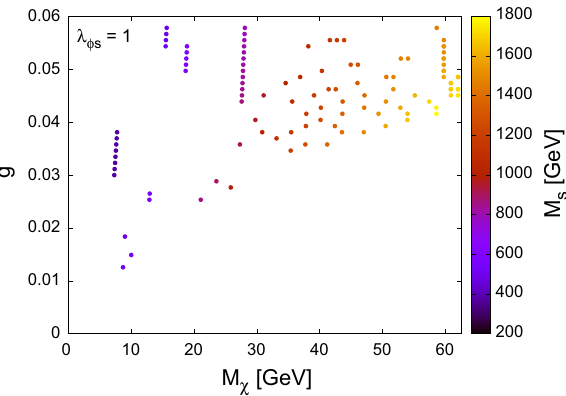
Fig. 14 Scatter points depict the ranges of parameter space in the mass of fermionic DM and g coupling for different values of M s , which are consistent with the observed relic